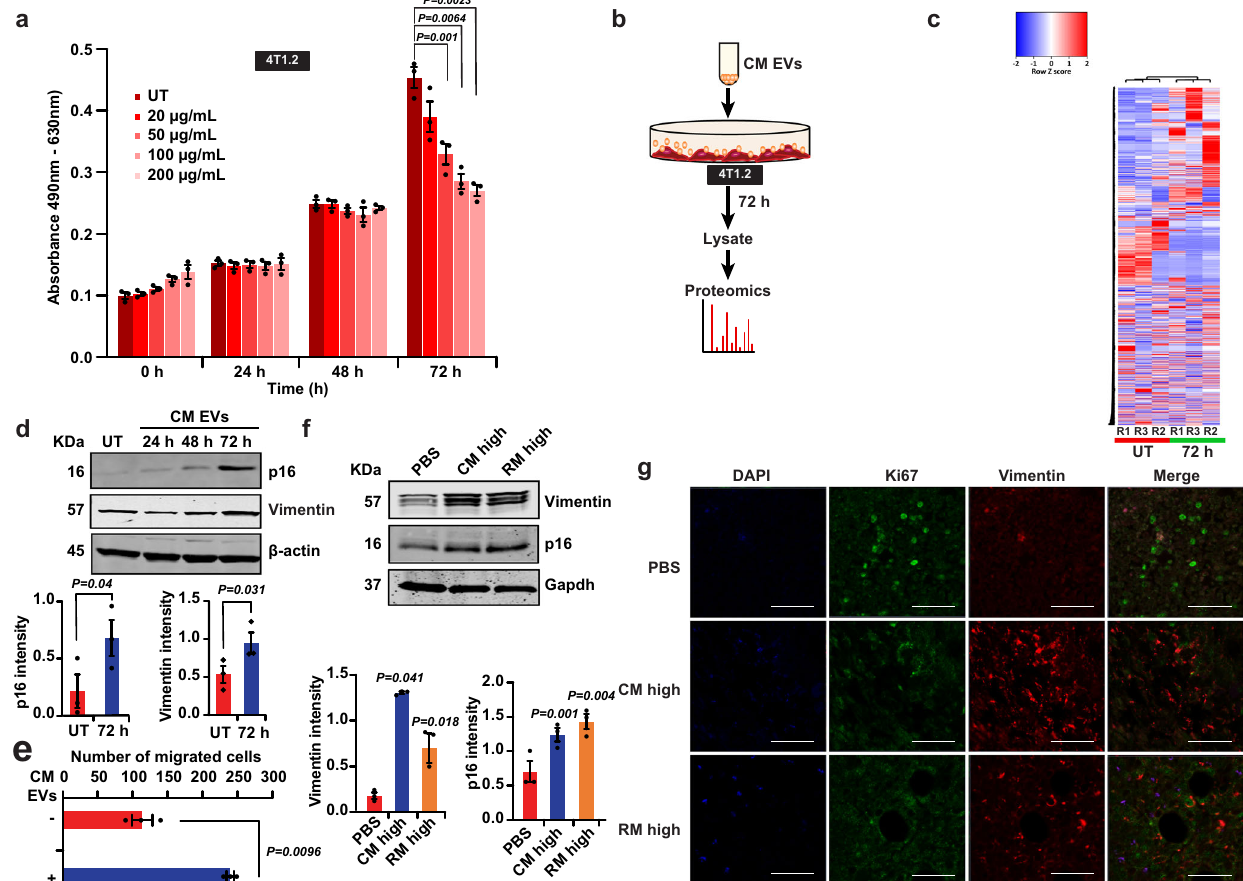
Fig. 6 Milk-derived EVs induce cellular senescence and epithelial-to-mesenchymal transition in cancer cells. a MTS-based proliferation assay on 4T1.2 breast cancer cells with increasing concentration of milk-derived EVs shows a dose-dependent reduction in metabolic activity at 72 h (dosage = 20, 50, 100 and 200 μ g/mL; n = 3). b Schematic representation of proteomics analysis performed on 4T1.2 breast cancer cells incubated with 100 μ g/mL of CM EVs for 72 h. c Heatmap highlighting the differential abundance of proteins in 4T1.2 breast cancer cells upon treatment with milk-derived EVs. d Western blot analysis shows the increase in the senescence marker p16 and cytoskeletal protein Vimentin upon treatment of 4T1.2 cells with milk-derived EVs in vitro (n = 3) . e , Treatment of 4T1.2 cells with milk-derived EVs increases the migration of breast cancer cells ( n = 3 ). f Western blotting of primary tumor isolated from mice orally administered with or without milk-derived EVs con fi rmed the upregulation of senescence regulator p16 and cytoskeletal protein Vimentin in vivo (n = 3 ) . g Immuno fl uorescence of primary tumor sections shows upregulation of Vimentin and reduction in cell proliferation marker Ki67 in mice orally gavaged with milk-derived EVs (n = 3). Scale bar represents 100 µ M. All data are represented as mean ± s.e.m. Statistical signi fi cance was determined by two-tailed t